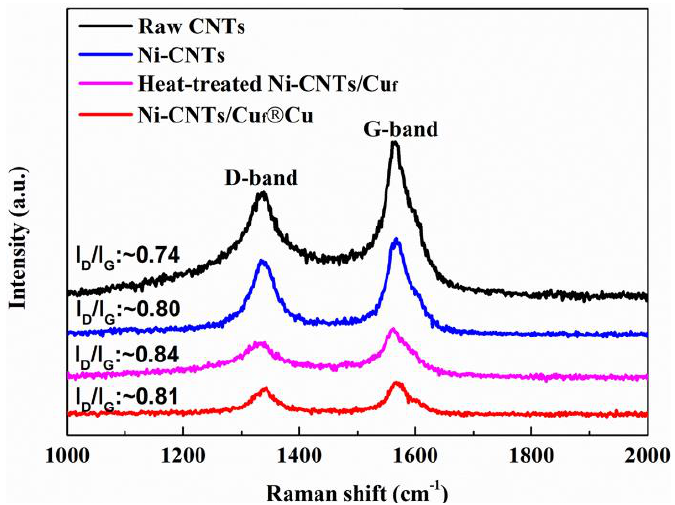
Figure 4. Raman spectra of raw CNTs, Ni-CNTs, and Ni-CNTs/Cu f after heat treatment and Ni- CNTs/Cu f ® Cu.